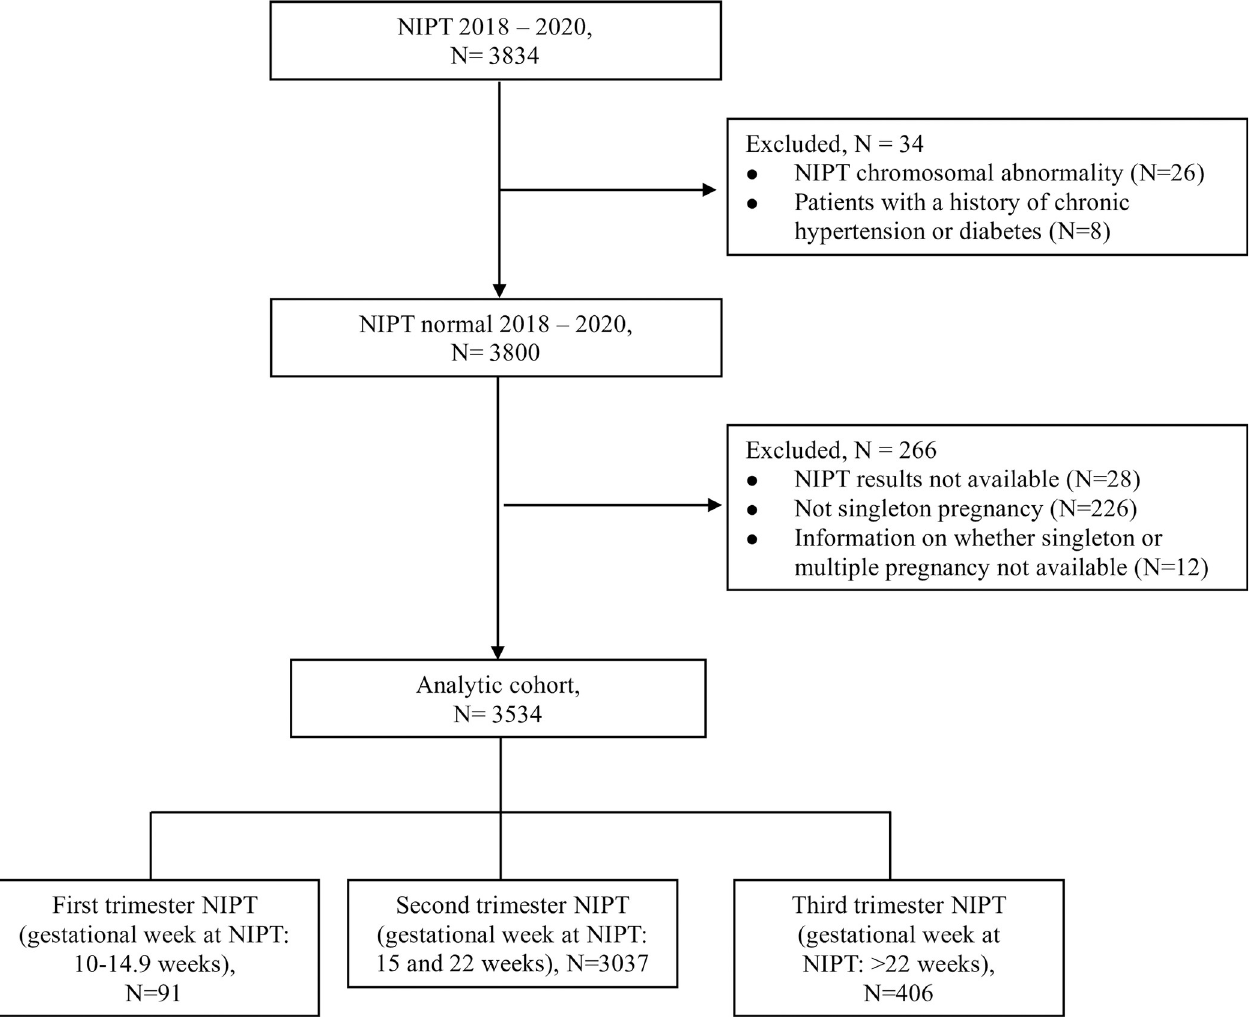
Fig 1. Flow chart defining the study population. The flow chart illustrates the filtering steps applied in the study. NIPT, noninvasive prenatal testing.